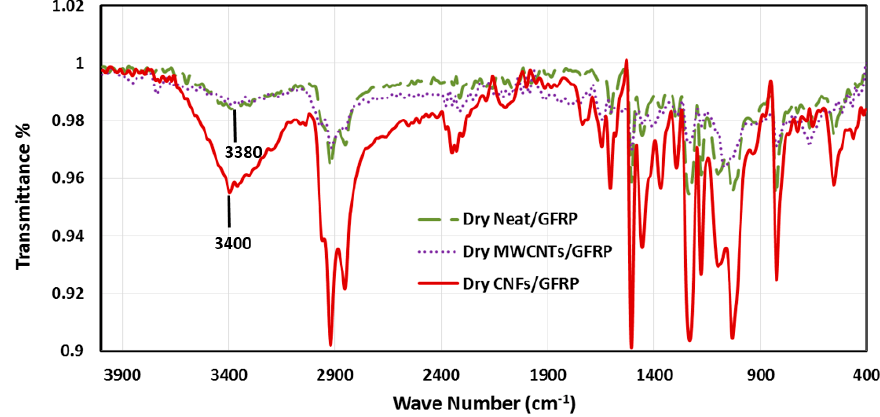
Figure 10. Fourier Transform Infrared (FTIR) spectra of neat/epoxy, 2.0 wt % CNFs/epoxy and 2.0 wt % MWCNTs/epoxy nanocomposites.